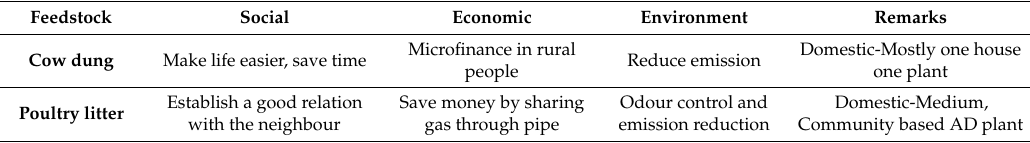
Table 7. Potential impact of different AD facility types.